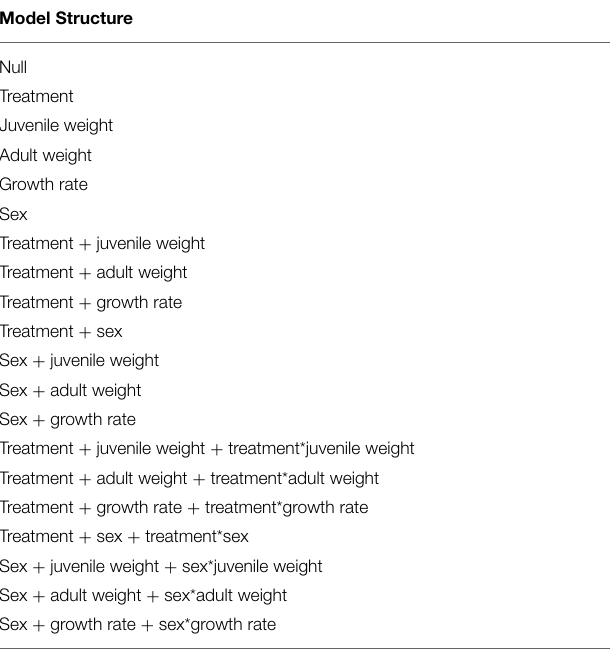
TABLE 1 | List of model structures used to analyze relationship between boldness, treatment, and life history characteristics.